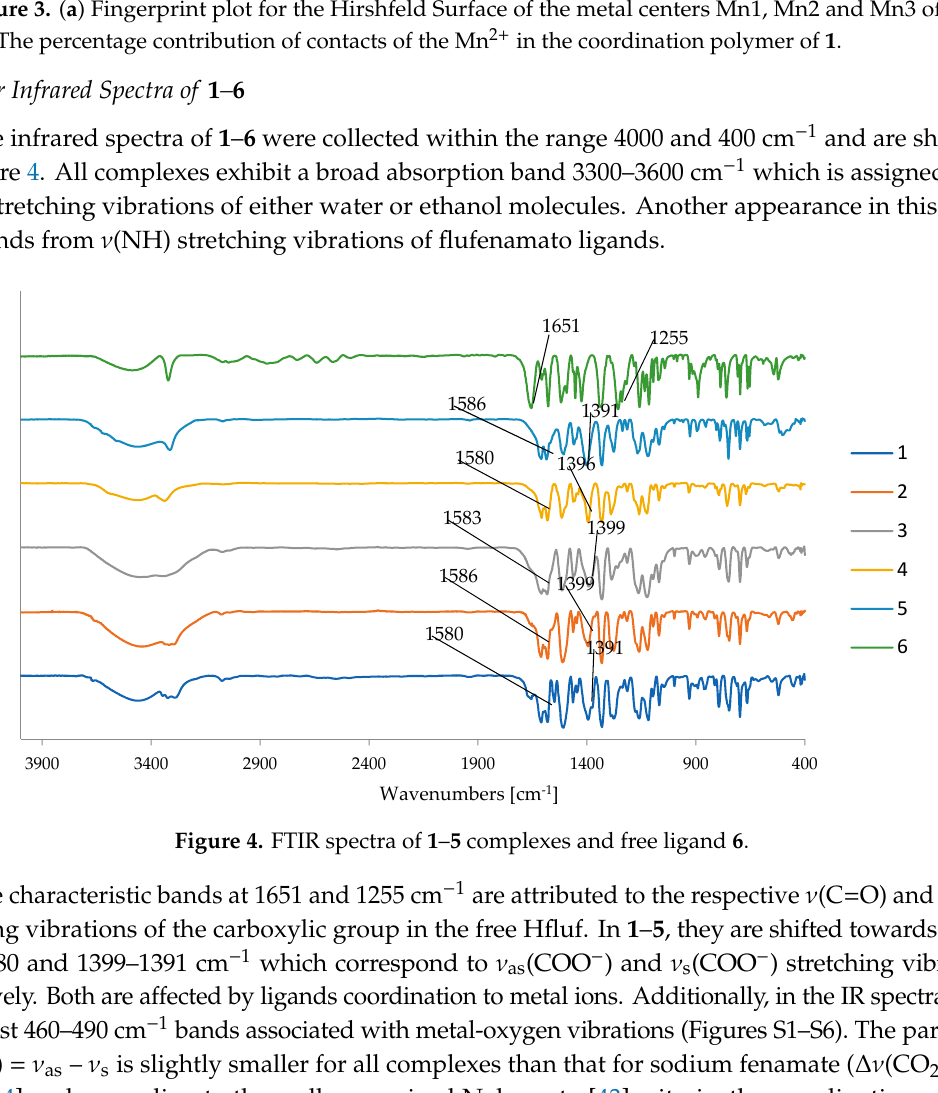
Figure 4. FTIR spectra of 1 – 5 complexes and free ligand 6 .